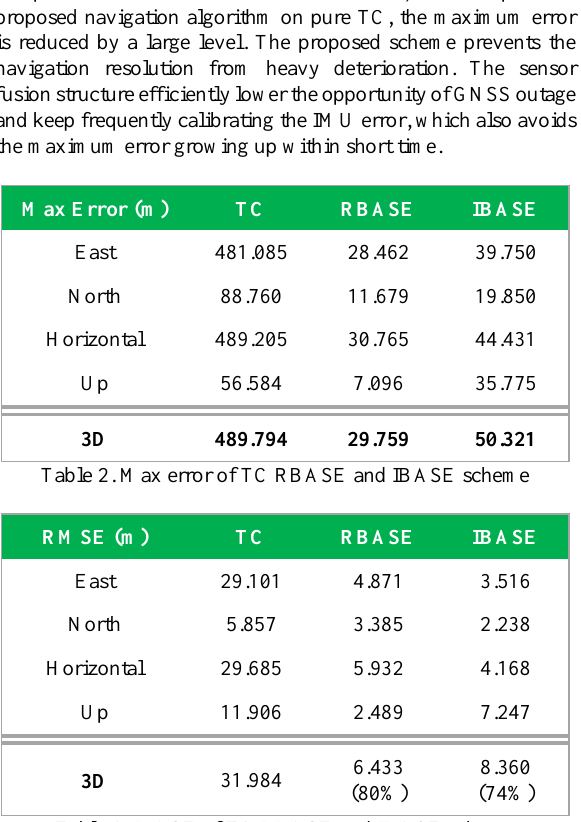
Figure. 10 Urban canyon case – II